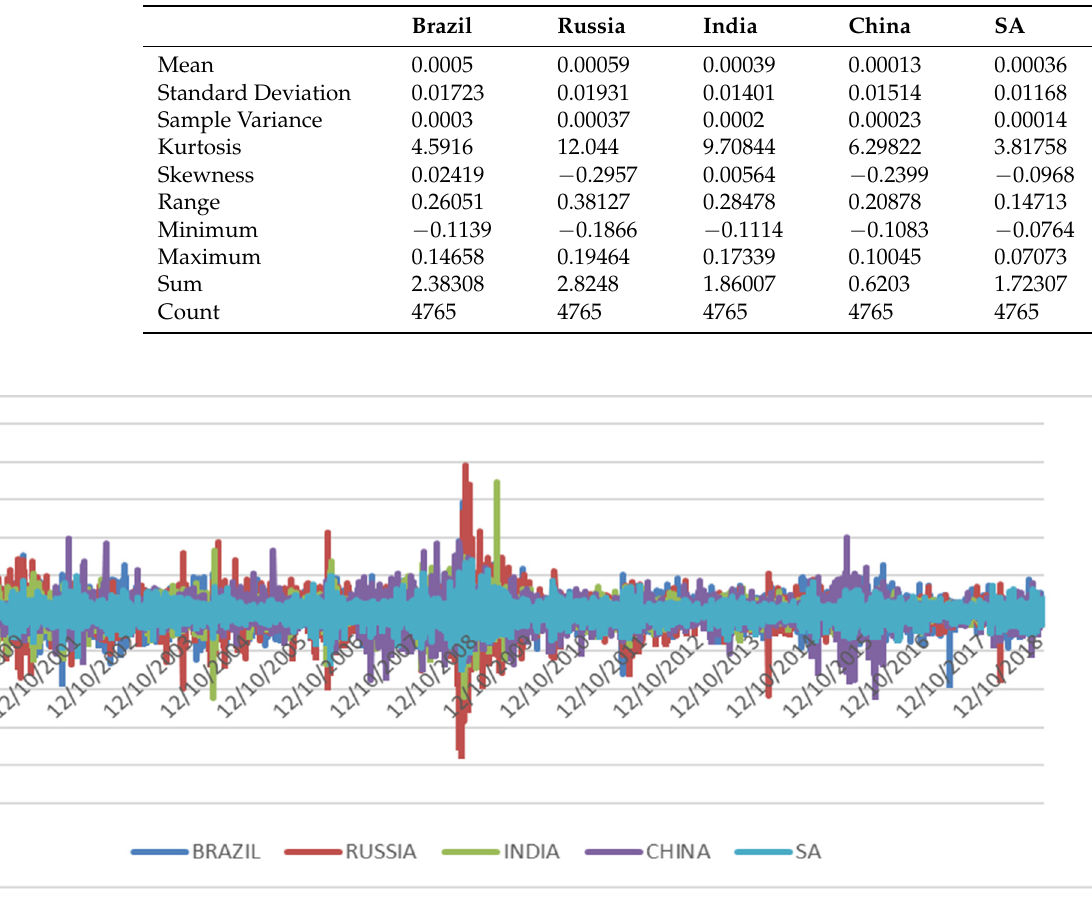
Figure 2. BRICS time series plot for the daily